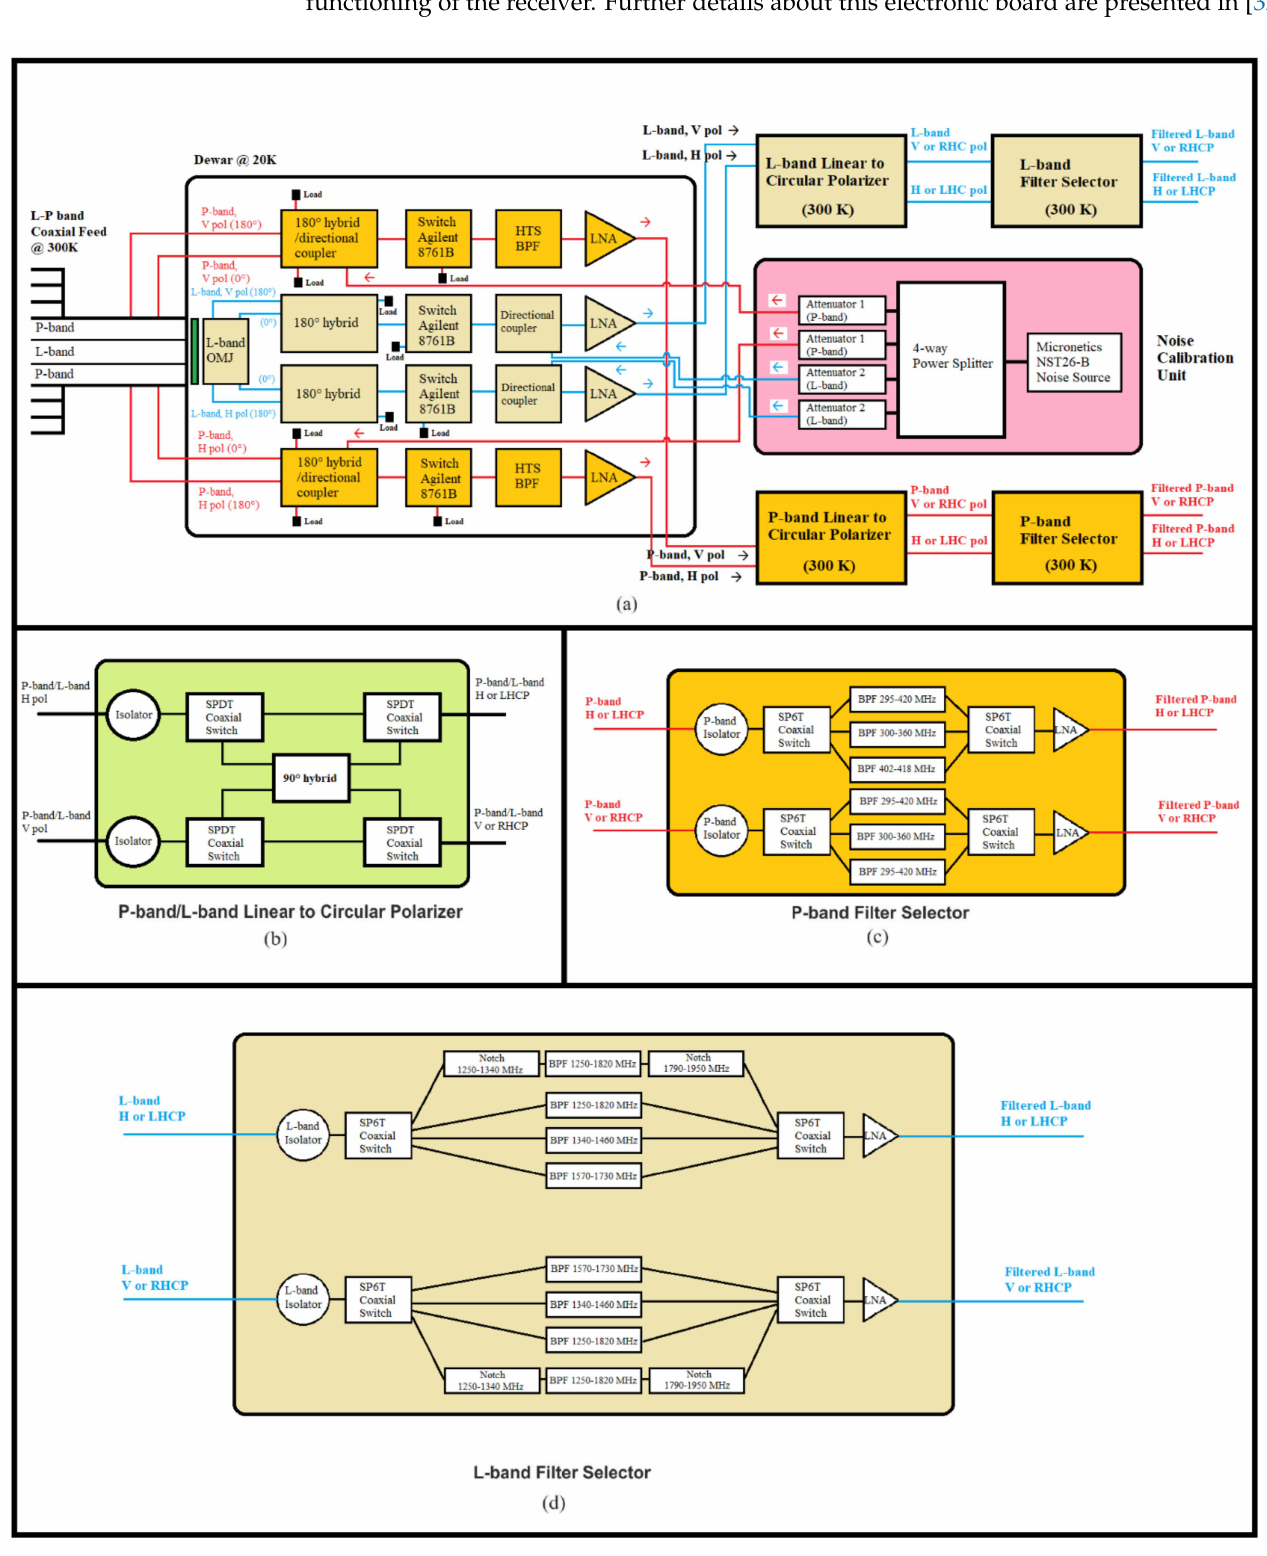
Figure 3. ( a – d ) Schematic of the L-P band receiver